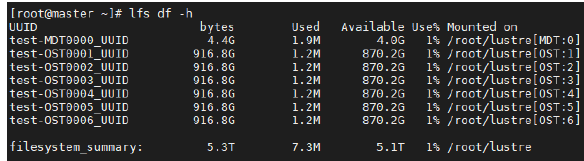
Figure 9. Lustre